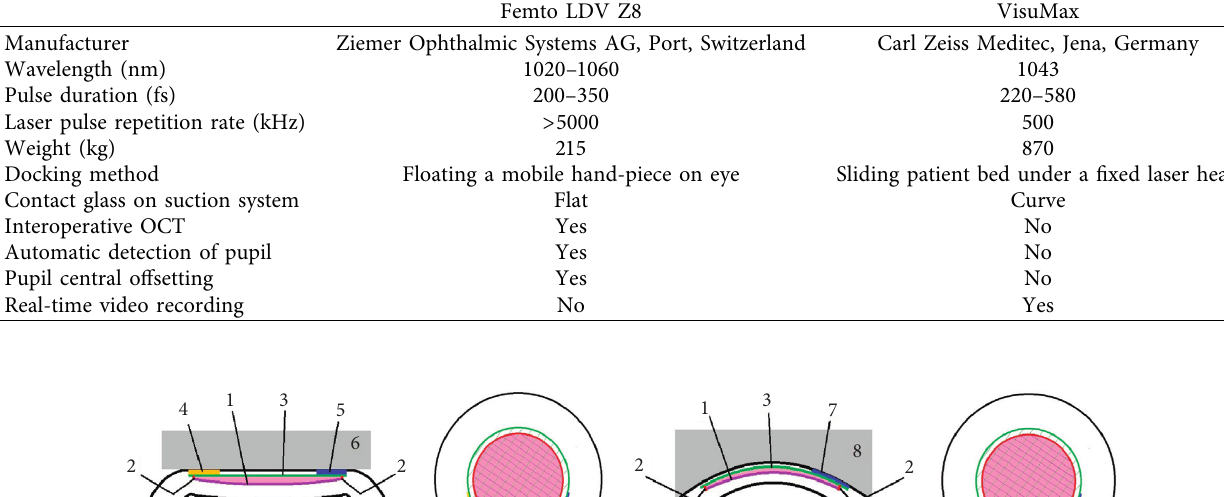
Table 1: Main equipment parameters of the two femtosecond laser platforms.